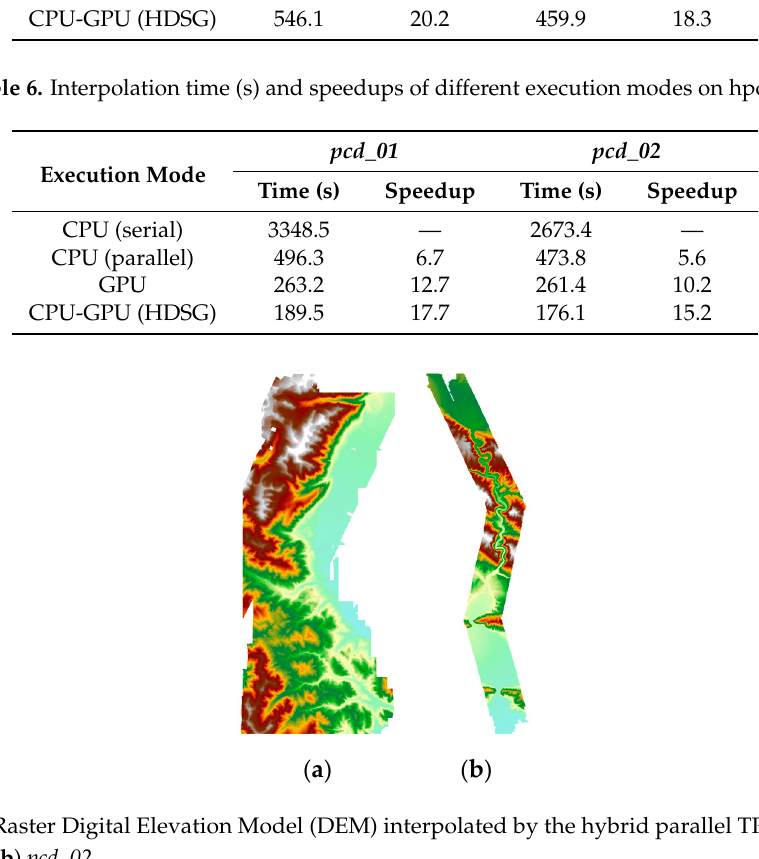
Table 5. Interpolation time (s) and speedups of different execution modes on hpc_01.